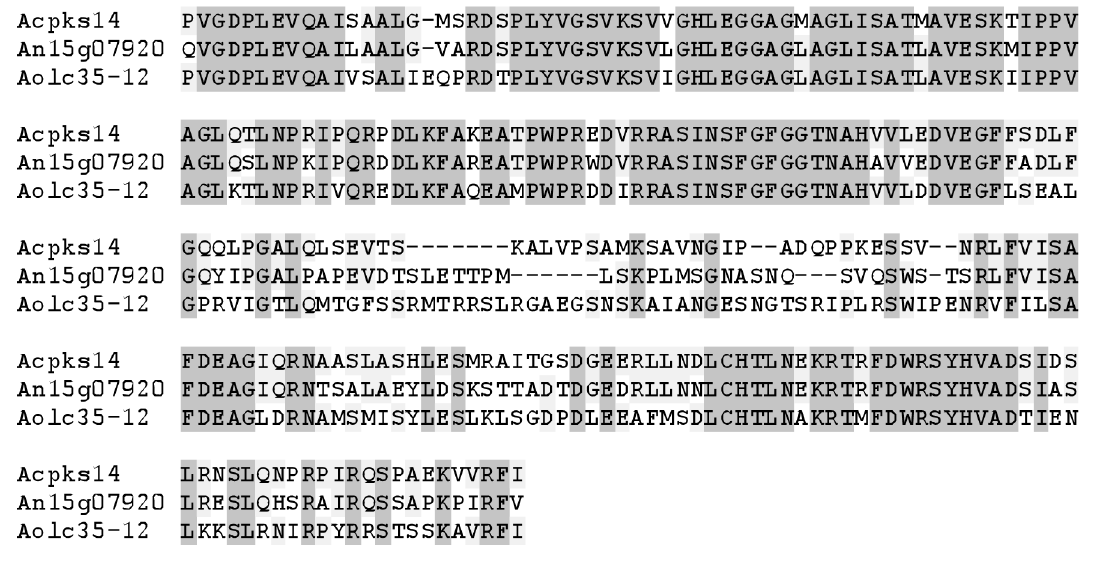
Figure 1. Alignment of deduced amino acid sequences of aolc35-12 ( Aspergillus westerdijkiae ), an15g07920 ( A. niger ) and acpks14 ( A. carbonarius ) P�S gene